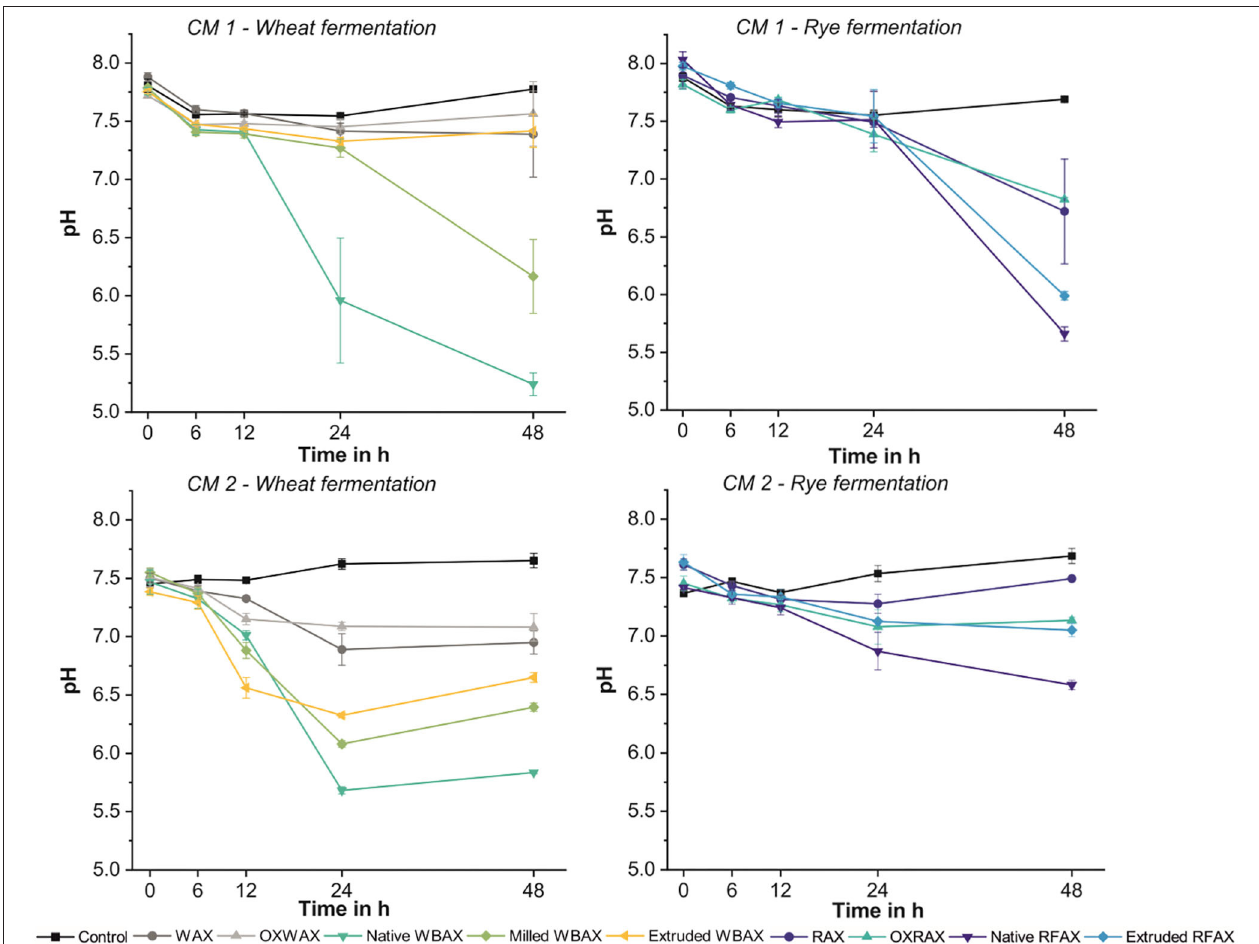
FIGURE 1 | pH acidification during 48 h in vitro fermentation of differently processed WBAX and RFAX by colon microbiota (CM) 1 and CM 2 expressed as average ± stdev pH ( n ≥ 4).